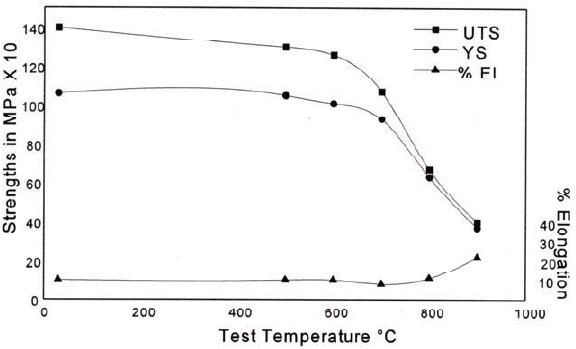
Figure 5. Mechanical properties of heat treated sheets at different temperatures and strain